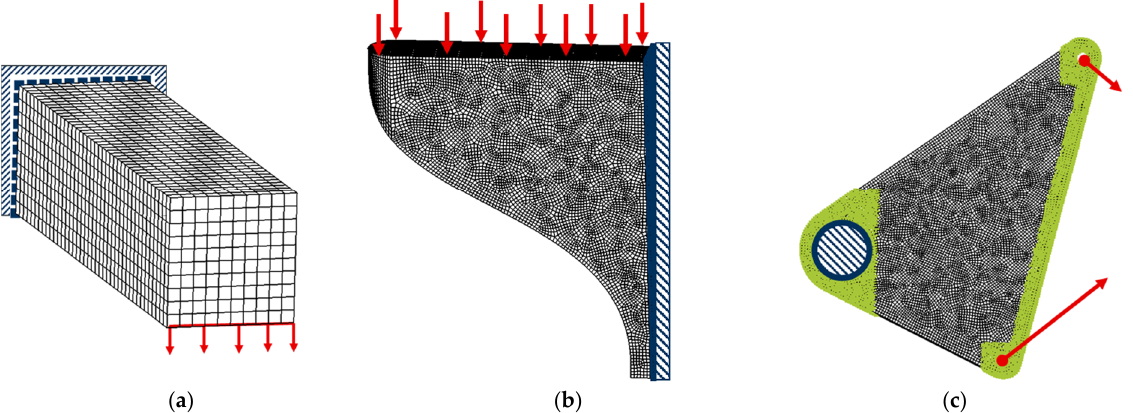
Figure 5. Overview of the application examples’ TO-setup: ( a ): Cantilever beam, ( b ): Bracket, ( c ): Rocker. Dark blue represents displacement constraints, the force vectors are displayed in red and green denote passive regions, if